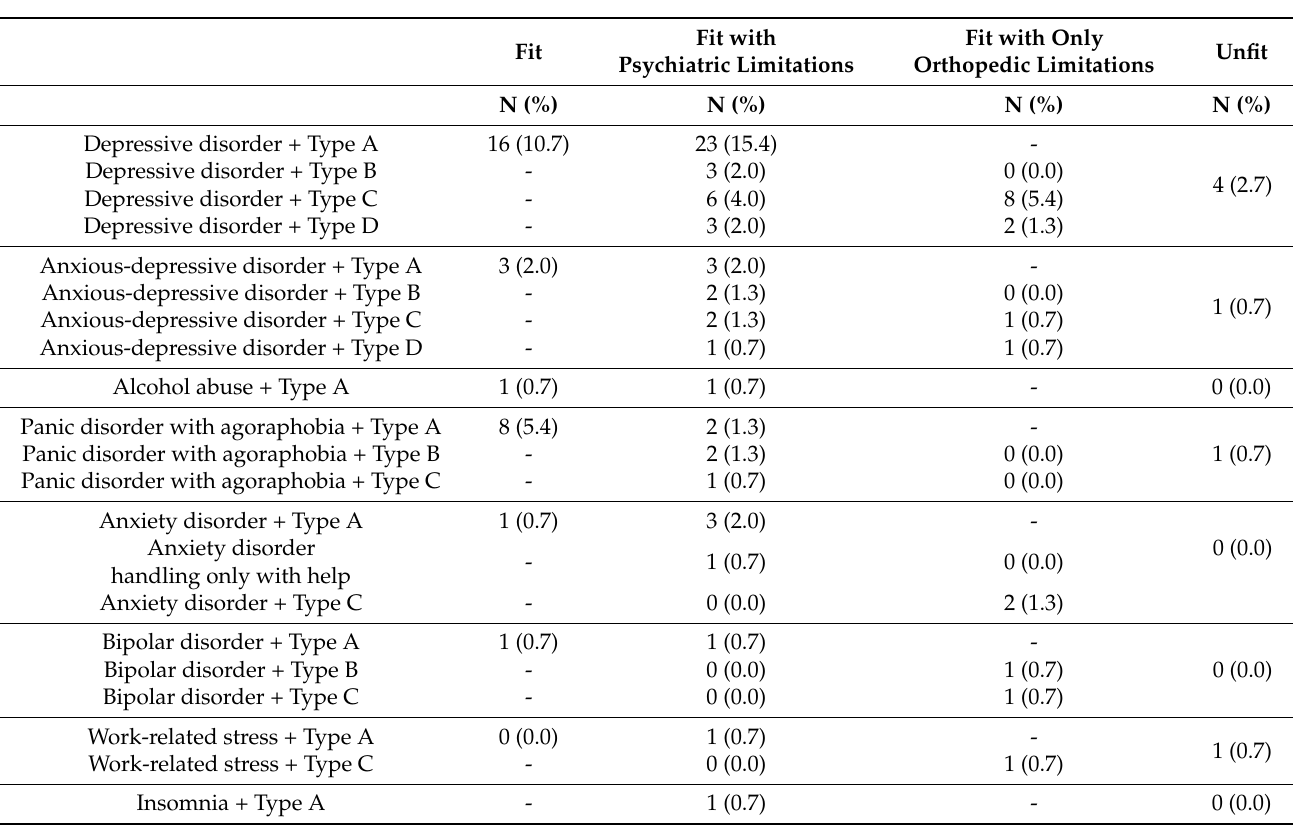
Table 3. Frequencies of participants with the same psychiatric diagnosis/same orthopedic limitation, according to fit